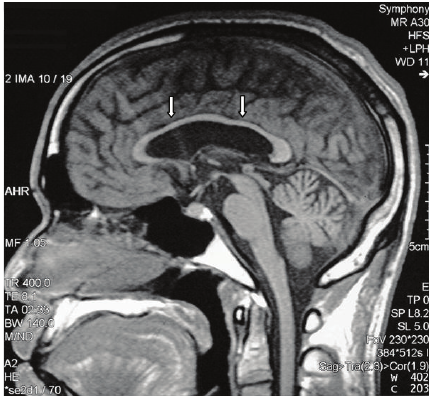
Figure 4: Sagittal T1 weighted MR image of the brain shows thinning of the corpus callosum (arrows). Cerebellar atrophy also evident with enlargement of cerebellar sulci.